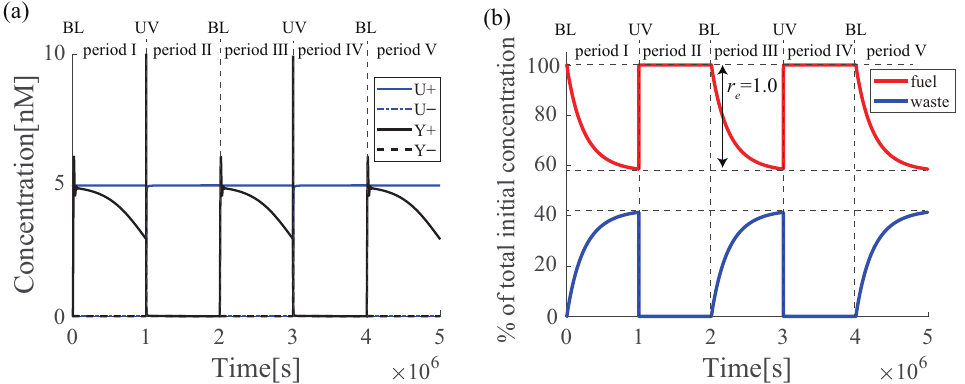
Figure 6. Simulation results of the renewable azo-PI controller. ( a ) Renewable performance of azo-PI controller; and ( b ) ratio of fuel DNA and waste DNA to the total initial concentration of the azo-PI controller. Since, the azo-PI controller appears in the reutilization (Figure A2), thus, the azo-PI controller consists of 220 DNA